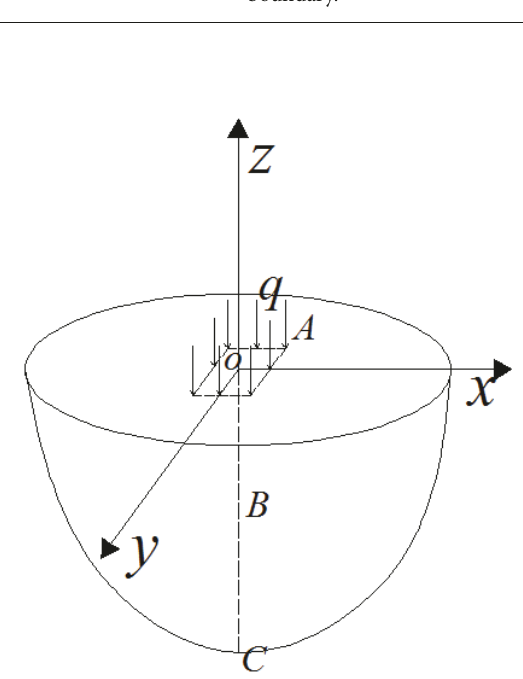
Figure 4: Semi-infinite body bearing normal uniform load.